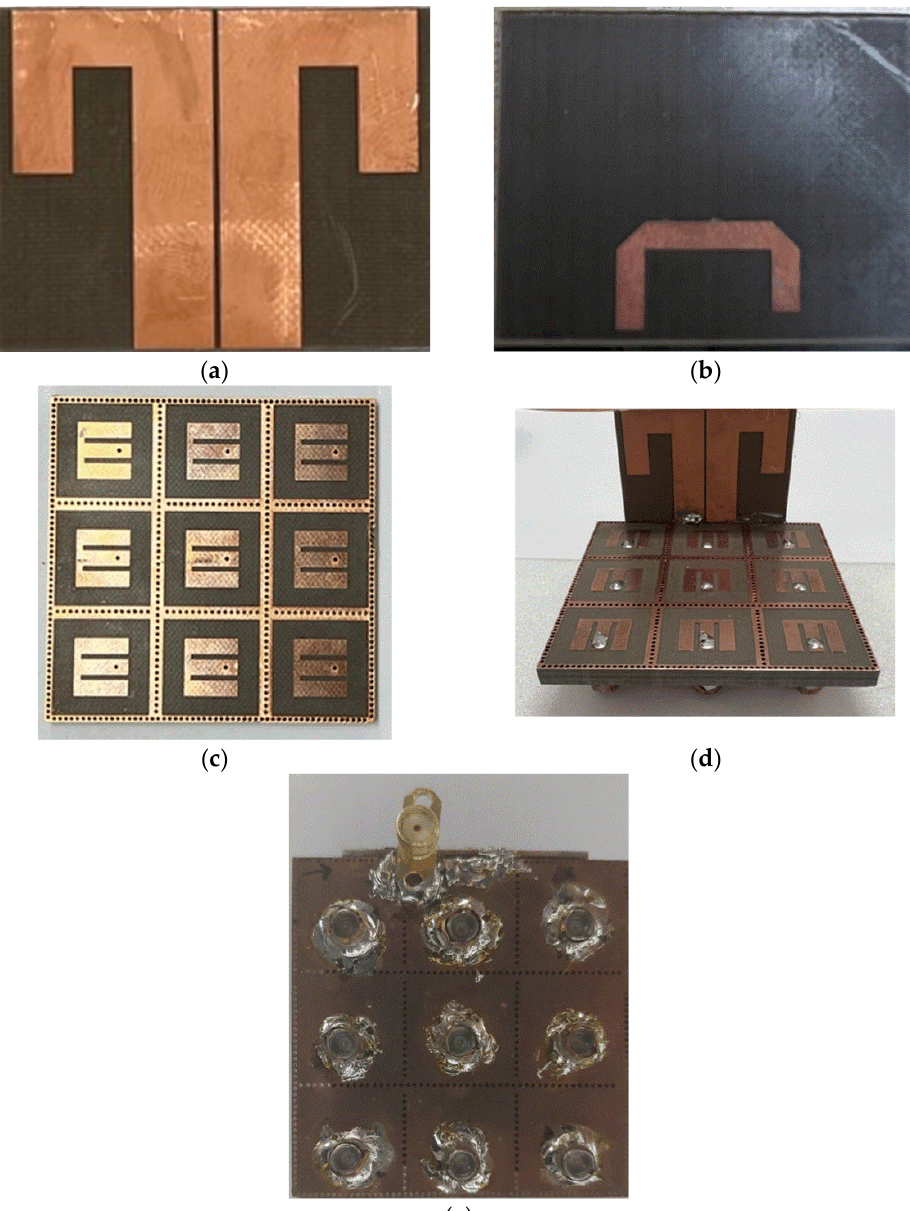
Figure 2. Photographs of the fabricated multi-band array antenna: ( a ) front view of the S-band antenna; ( b ) back view of the S-band antenna; ( c ) top view of the X-band antenna; ( d ) isometric view of the assembled unit-cell; ( e ) bottom view of the assembled unit-cell.